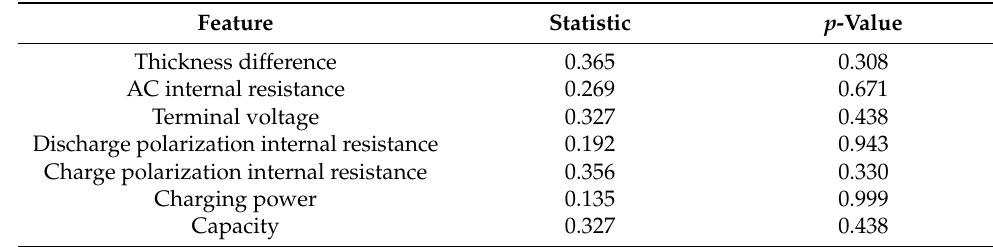
Figure 6. Cumulative distribution curves of training and test sets with different parameters. ( a ) Difference in volume expansion thickness; ( b ) AC internal resistance; ( c ) terminal voltage; ( d ) discharge polarization internal resistance; ( e ) charge polarization internal resistance; ( f ) charging power; ( g ) capacity. Table 1. KS-test results.